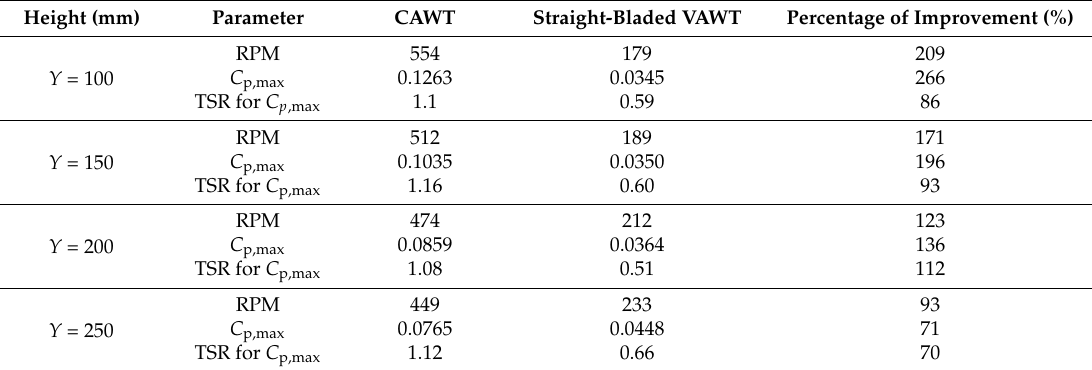
Table 3. Summary of the experimental results for the CAWT and the